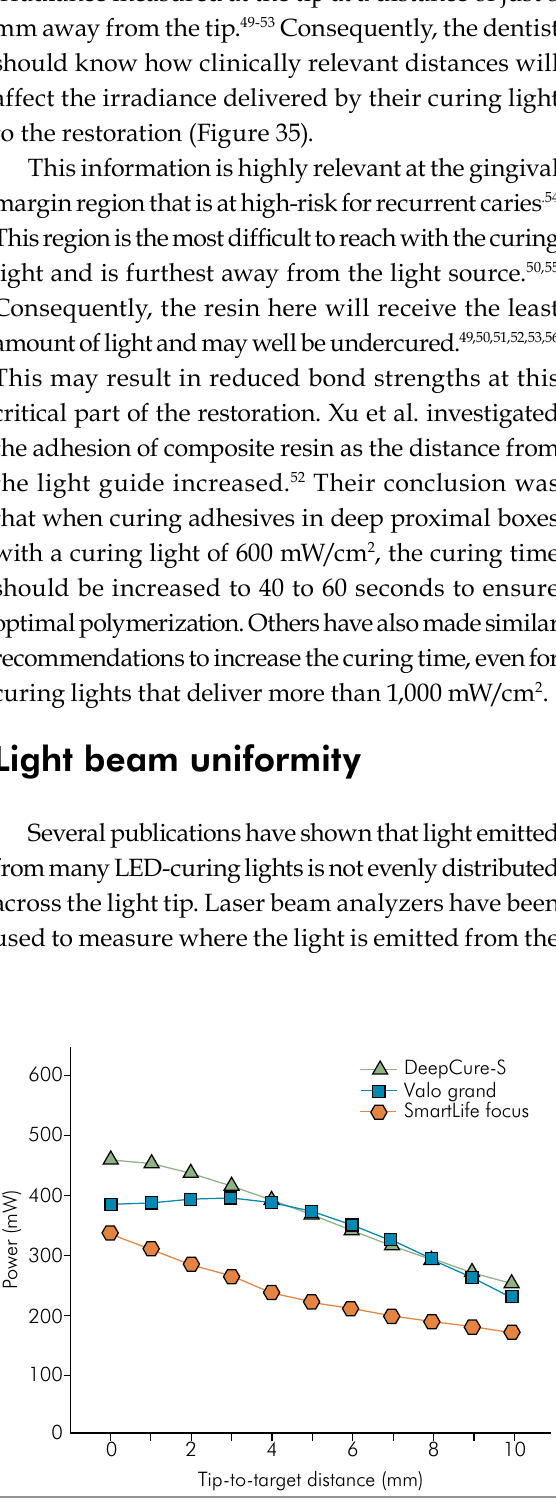
Figure 35. Power (mW) versus tip-to-target distance (mm) graph showing how the distances affect the irradiance delivered by three curing